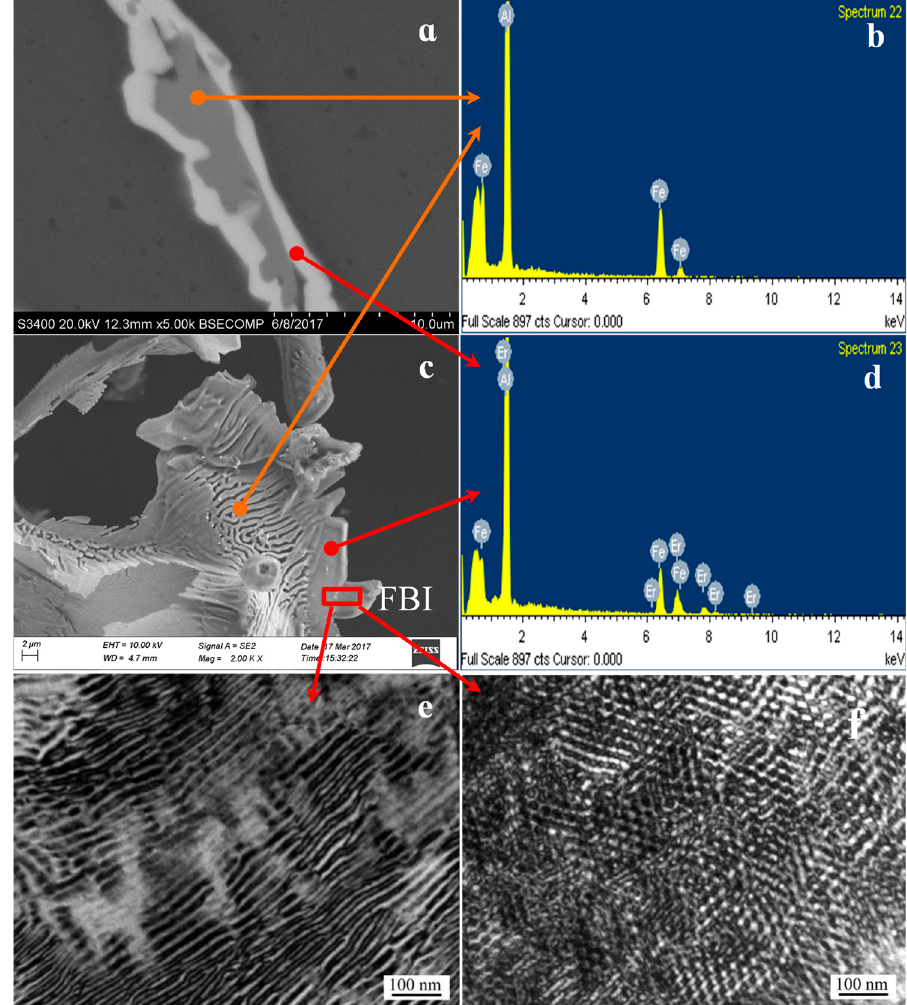
Figure 5. Transmission electron microscopy (TEM) images, SEM and EDS of Al 4 Er phase. ( a,c ) SEM image of Al 4 Er in grain boundary; ( b,d ) EDS analysis; ( e,f ) TEM image of Al 4 Er in grain.